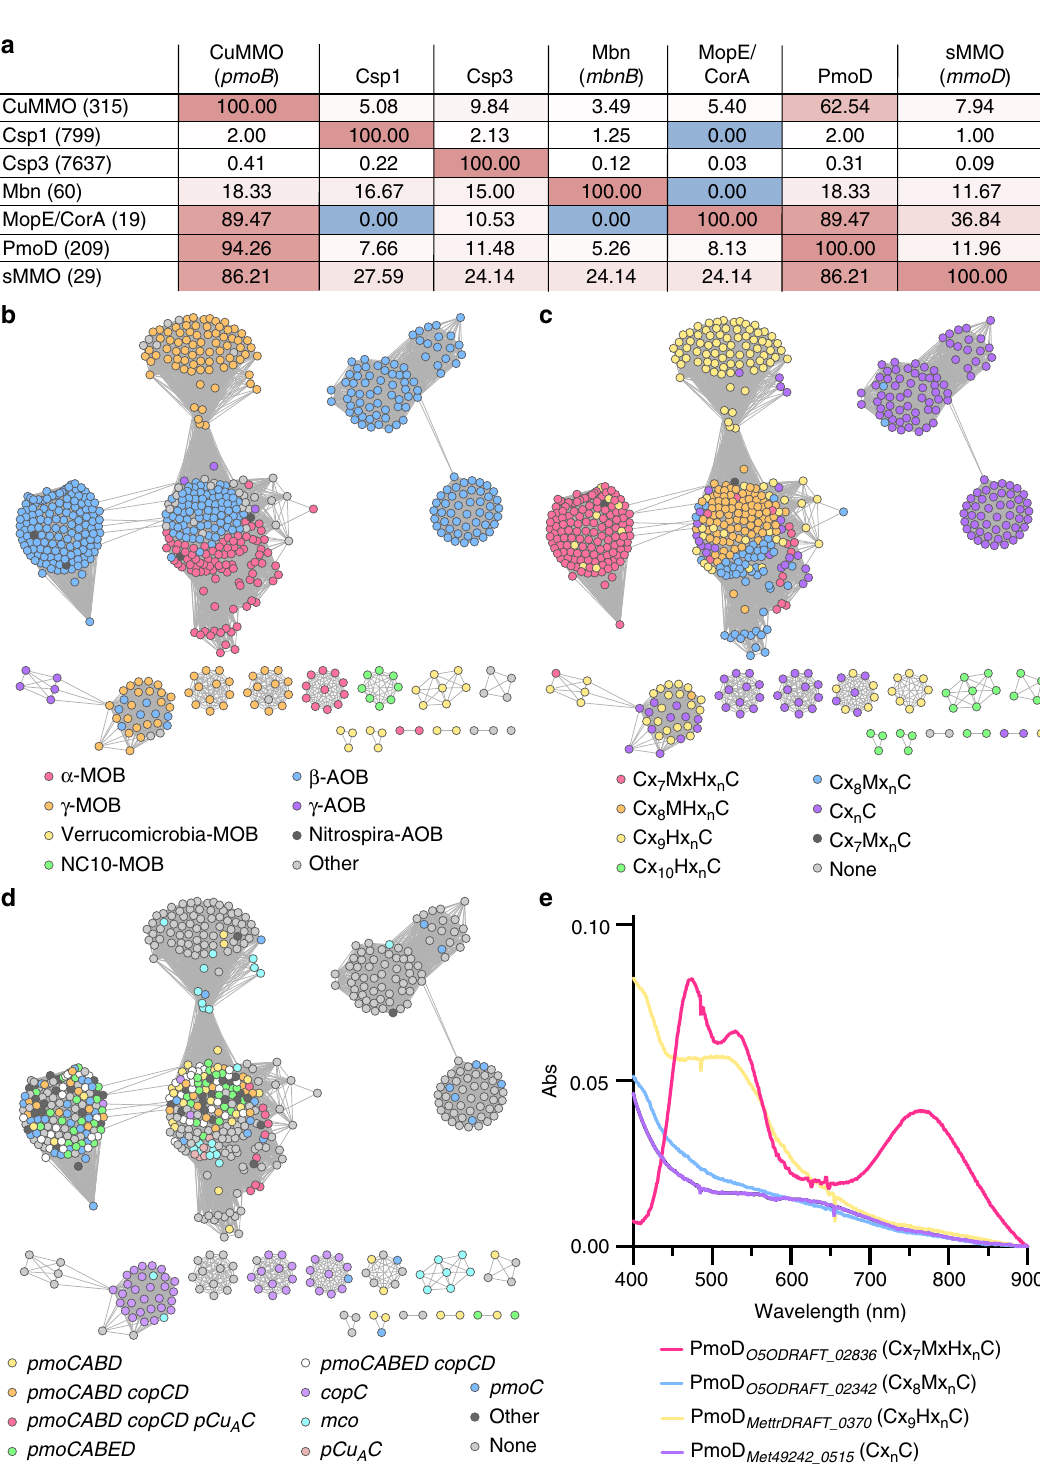
Fig. 4 PmoD subfamilies and their connections to copper homeostasis. a Genomes present in the JGI/IMG database were analyzed for the presence of genes with a proposed relationship to the methanotroph copper homeostasis, including csp1 / 2 (TIGR04401), copper membrane monooxygenases (CuMMOs) via a / pmoB (PF04744/TIGR03079), Mbn via mbnB (TIGR04159), pmoD (the dataset in this paper), csp3 /DUF326 (PF03860), mopE / corA